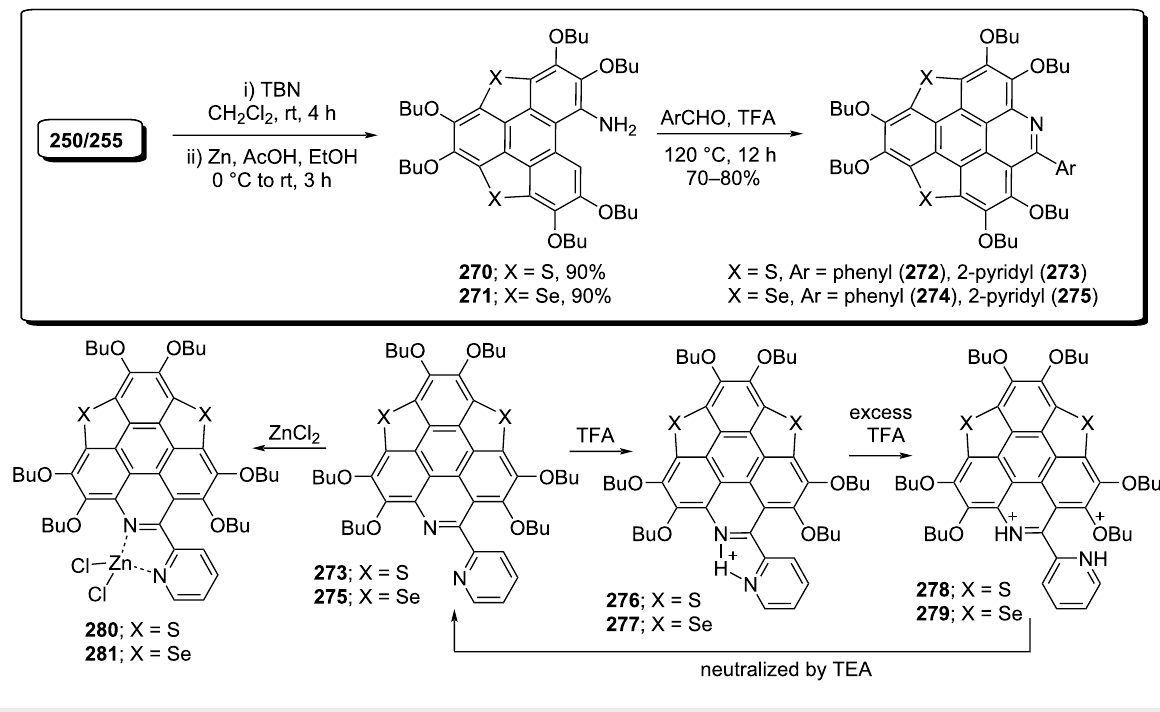
Scheme 62: Synthesis of sumanene-type hetero polycyclic compounds.